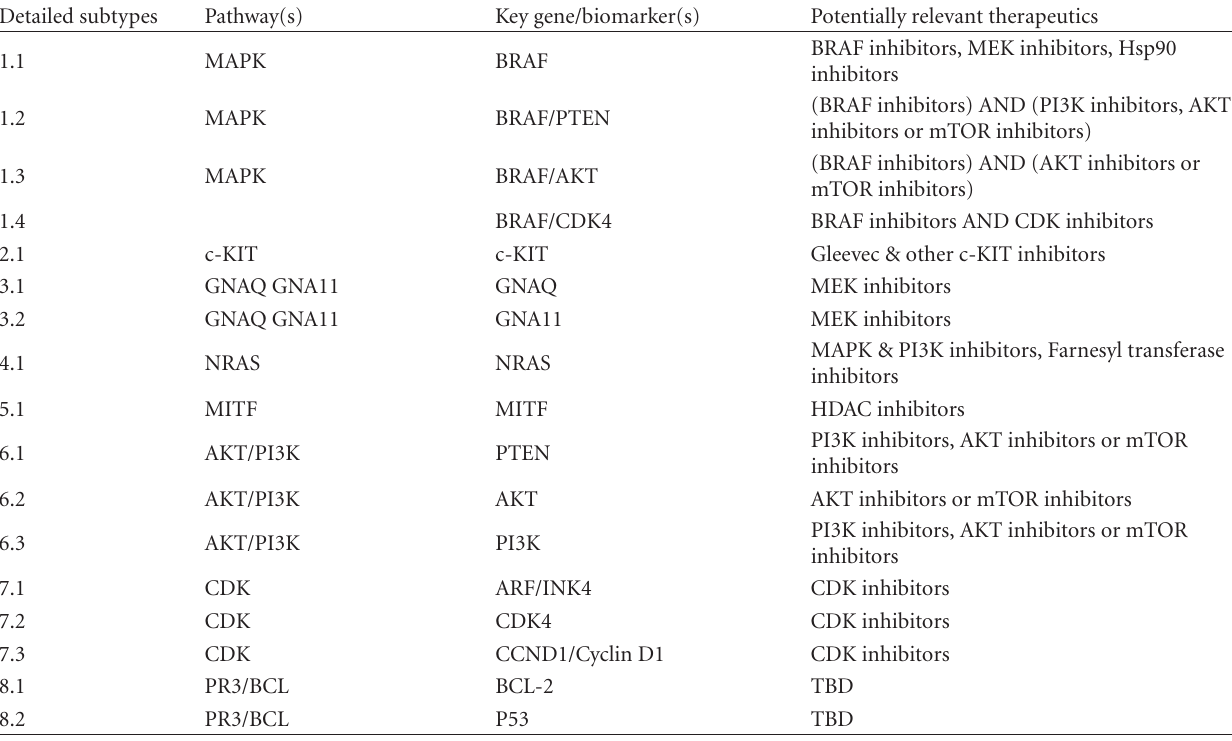
Table 5: Principal and secundary melanoma molecular subtypes